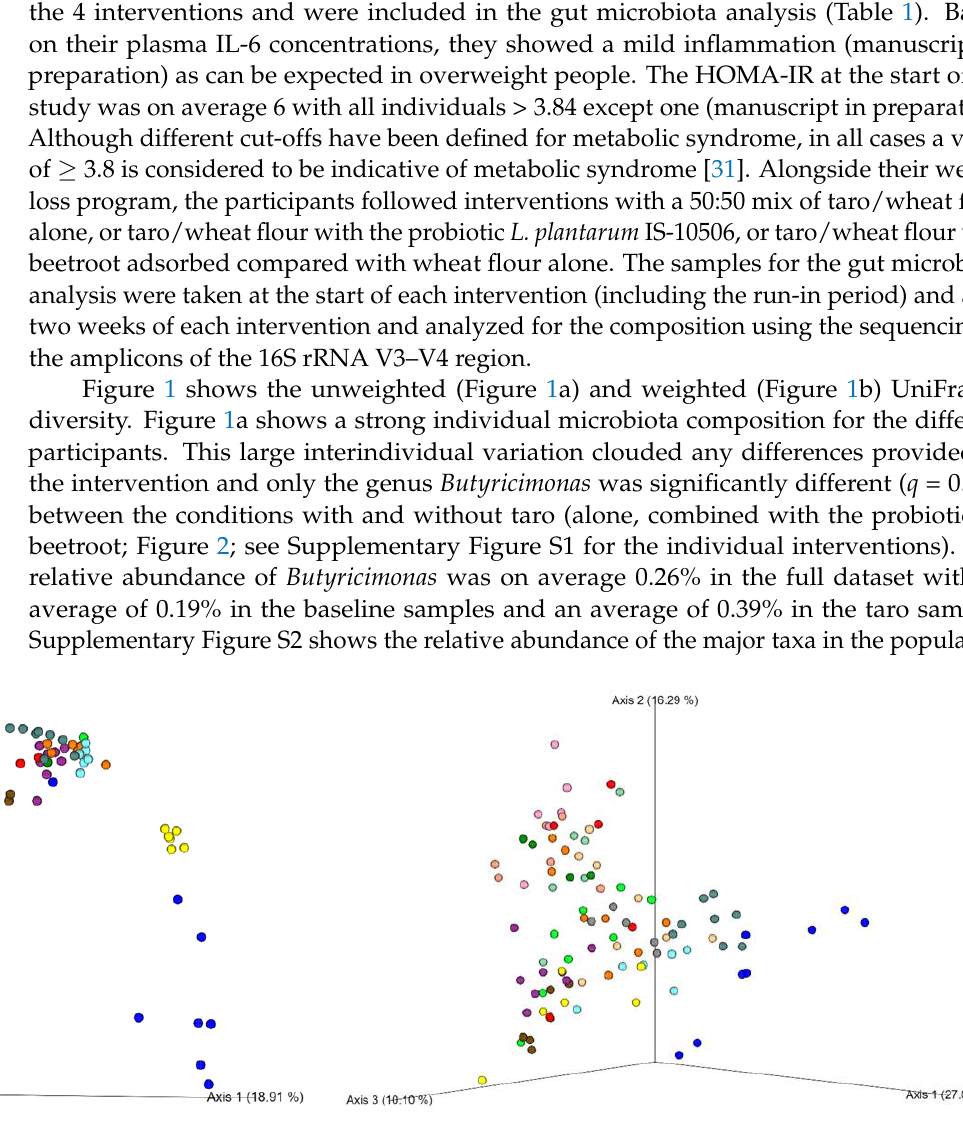
Figure 2. Difference in Butyricimonas between the control (including four baseline samples and the end sample after control intervention) and taro feeding (end samples after taro, taro + probiotic, and taro + beetroot).